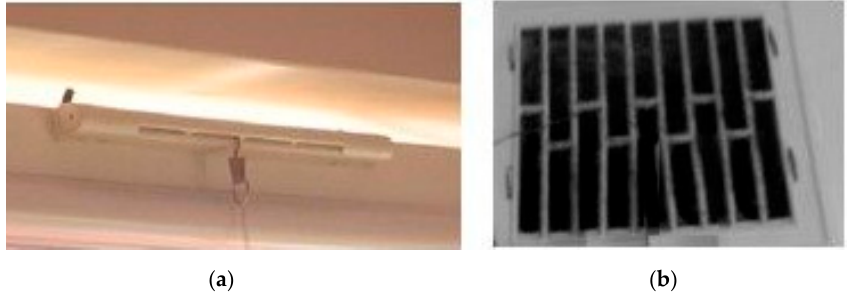
Figure 3. Inlet gap ( a ) and outlet vent ( b ) in research.